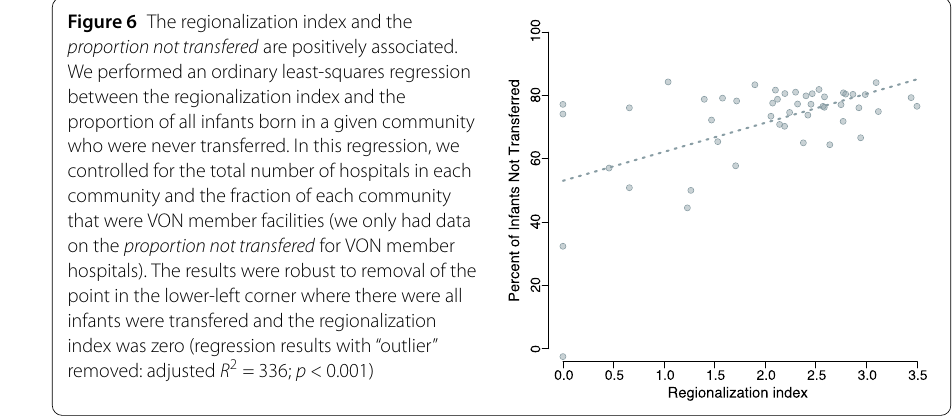
Table 3 Association between proportion not transfered and community-level network metrics. In the regression models, we controlled for variation in the number of hospitals and the fraction of VON member hospitals within each community